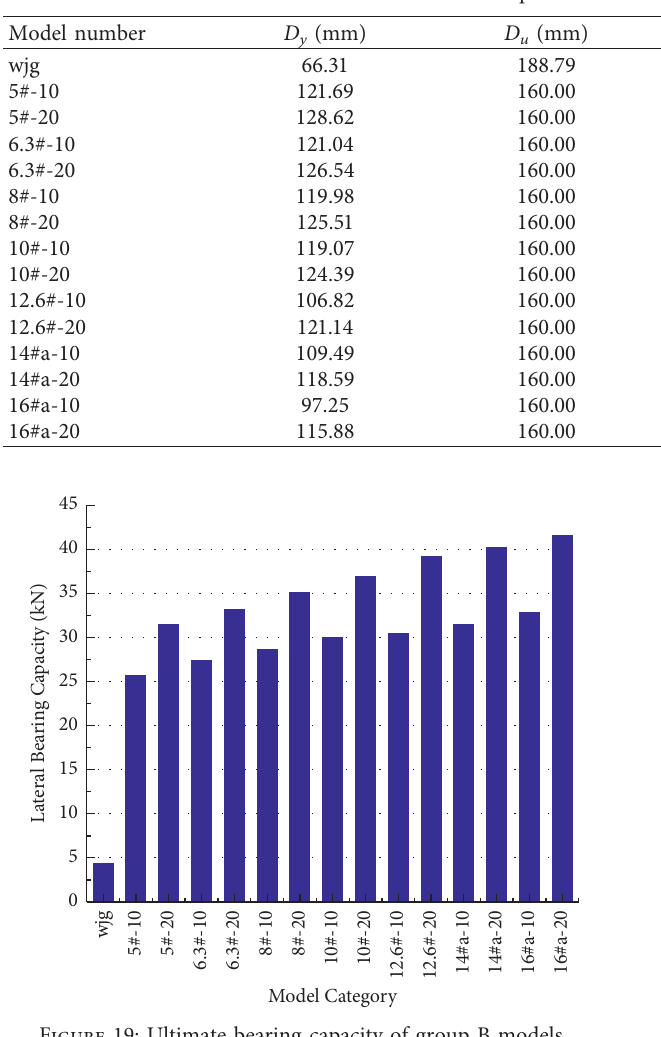
Table 7: Seismic performance indexes of group B